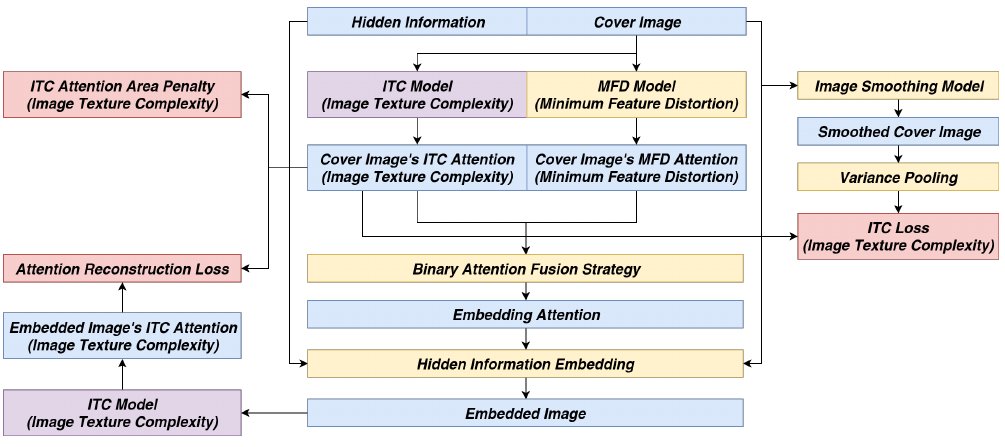
Figure 13. The 1st phase fine-tune pipeline.